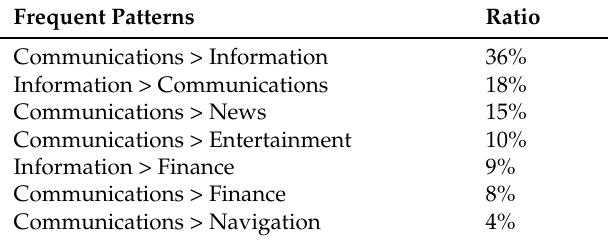
Table 4. Shortest frequent time-series